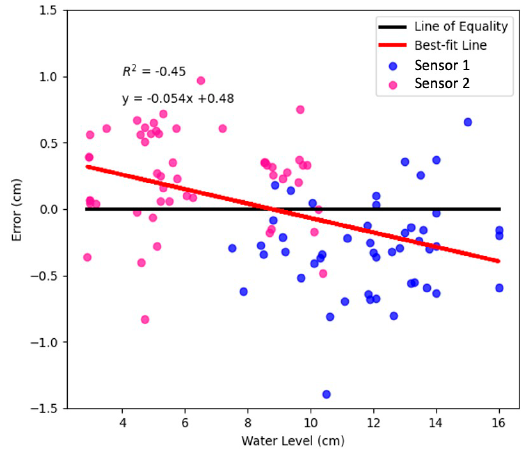
Figure 9. Comparison of errors of Sensors 1 and 2 with water level depth under laboratory condi- tions.